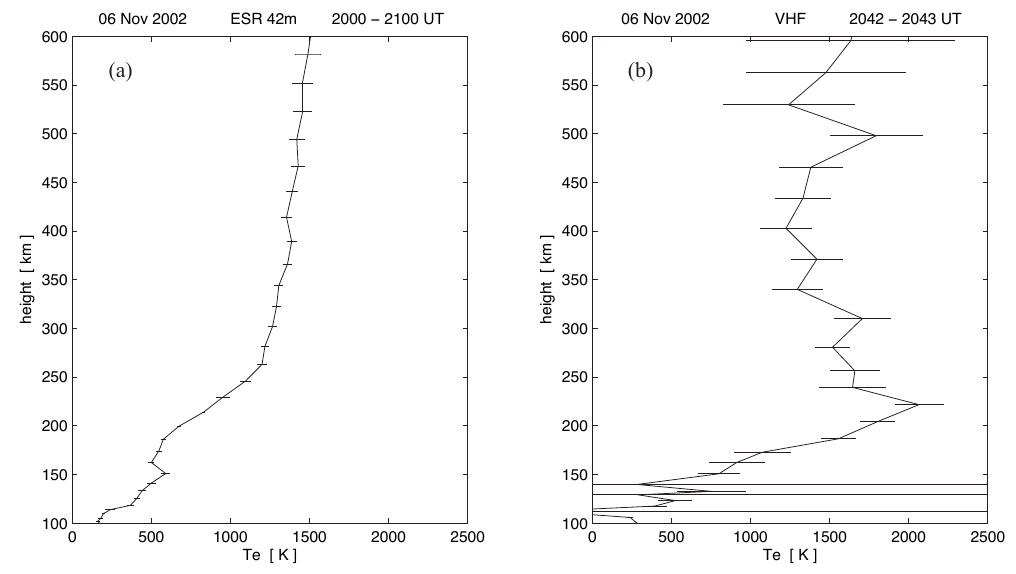
Fig. 2. (a) The polar cap altitude profile of T e by the ESR 42m radar and (b) the altitude profile of T e by the low-elevation VHF radar.